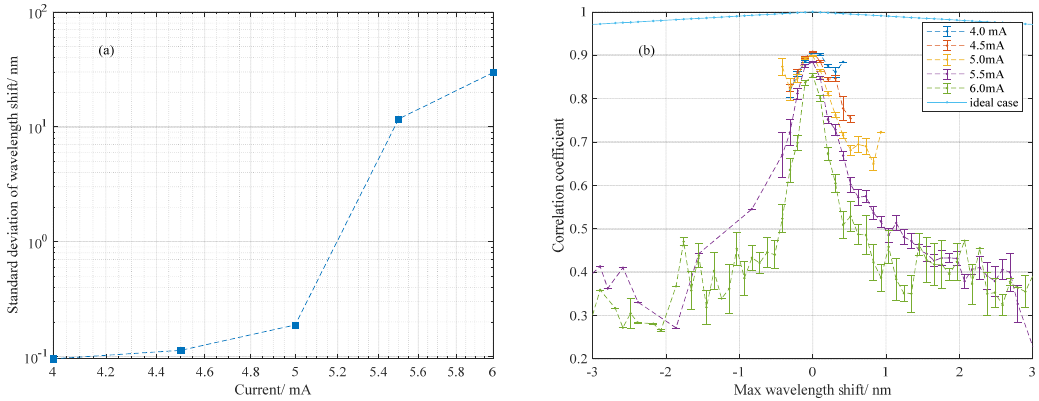
Figure 5. ( a ) Standard deviation of wavelength shift in fused range as stress varied with applied arc current; ( b ) distribution of correlation coefficients for maximum wavelength shift at different